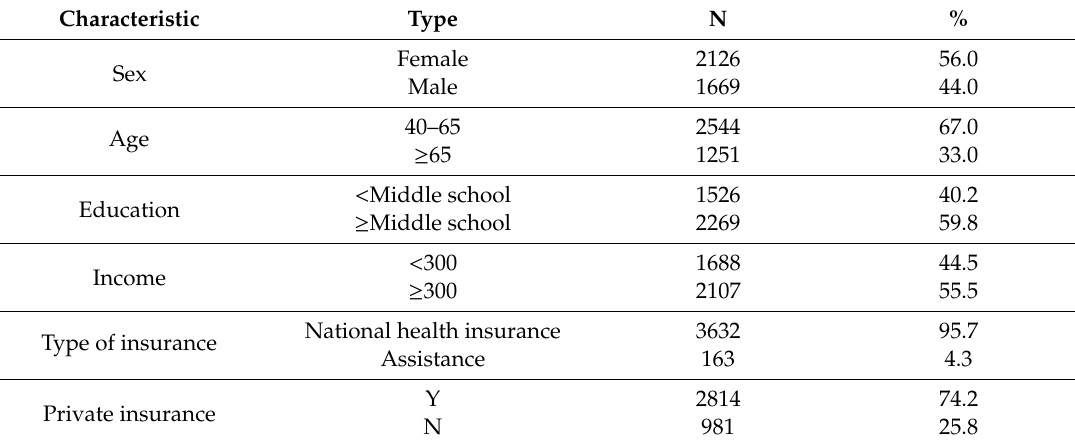
Table 2. Demographic characteristics ( n =